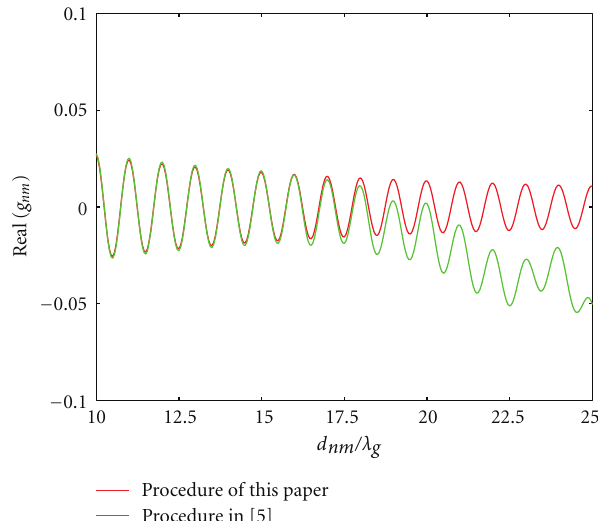
Figure 6: Real part of the mutual coupling coe ffi cient g nm , θ = 45 ◦ . The results for d nm < 10 λ g are not shown since the curves virtually overlap.